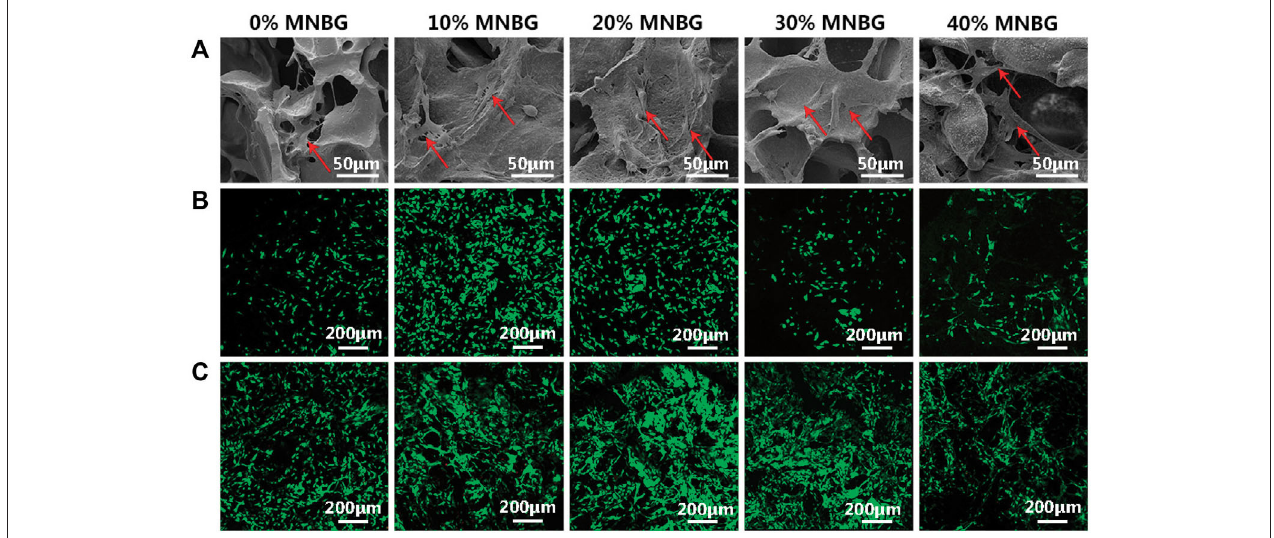
FIGURE 5 | Cell attachment and cell viability evaluation on scaffolds. (A) SEM images showing the mBMSCs attachment and spreading at day 1 (Red row in SEM images). (B,C) Cell viability detected by Live-Dead assay suggesting the good cell viability on the surface of scaffolds at (B) day 1 and (C) day 5. Green represents living cells and red represents dead cells.